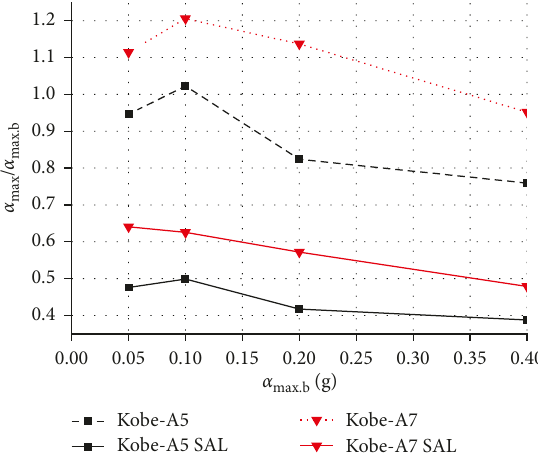
Figure 14: Comparison of amplification factor.